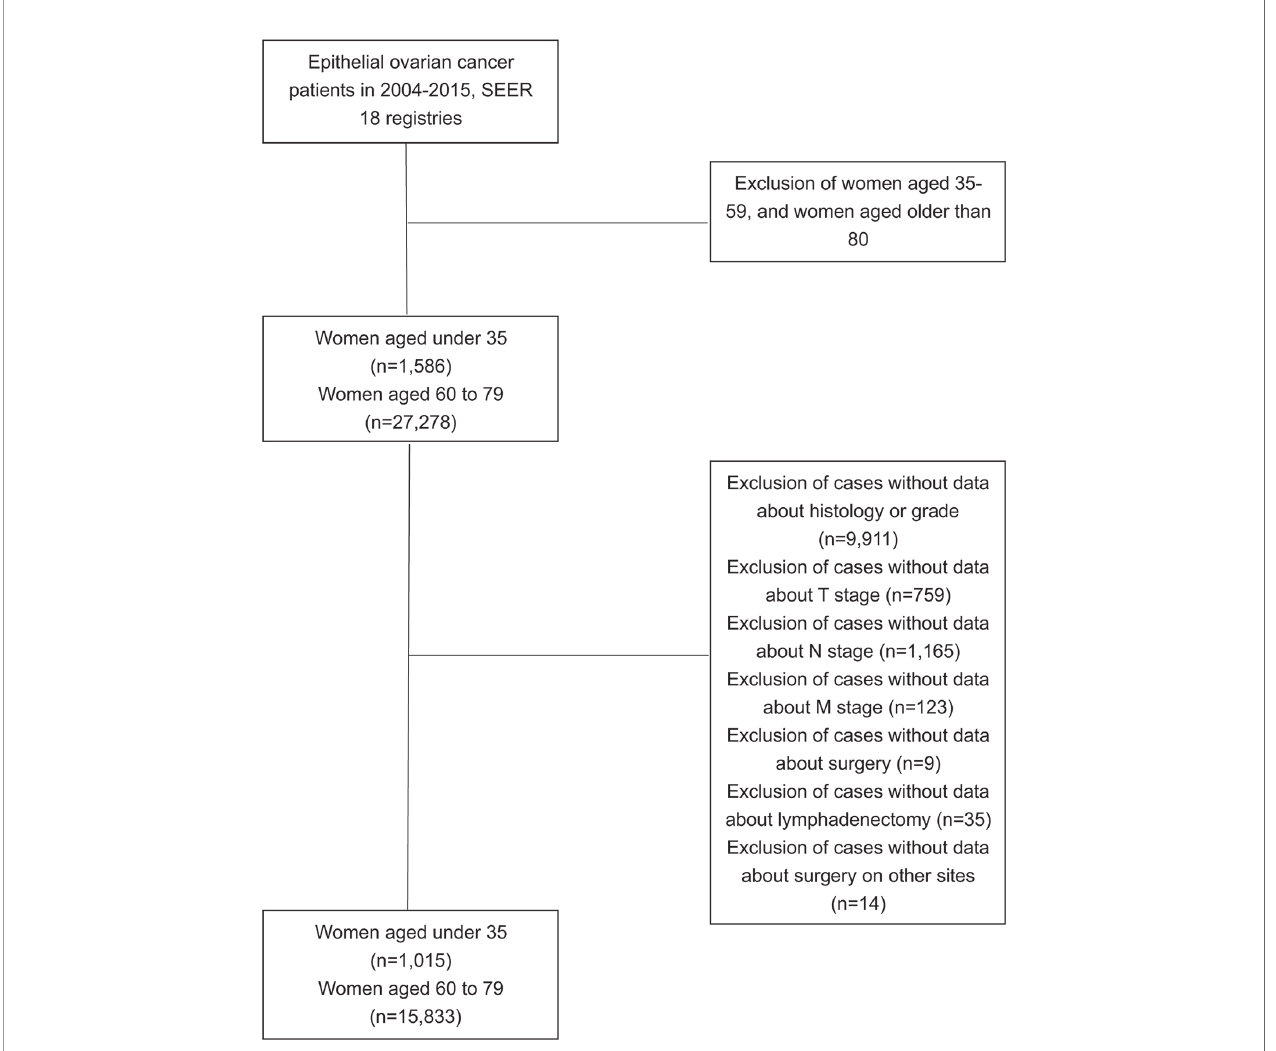
FIGURE 1 | Flow diagram for patient